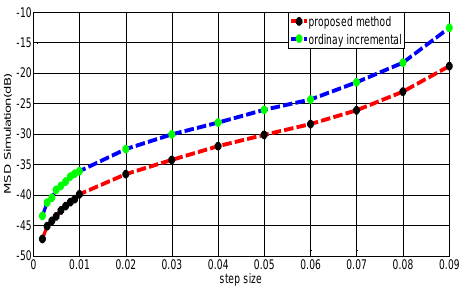
Figure 7. MSD differences for a variety of step sizes (4 nodes are